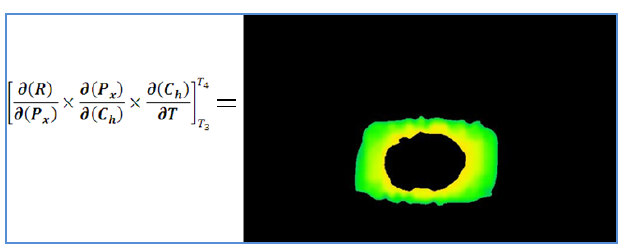
Figure 19. Chromatics value for red alarm temperature level with canonical formation